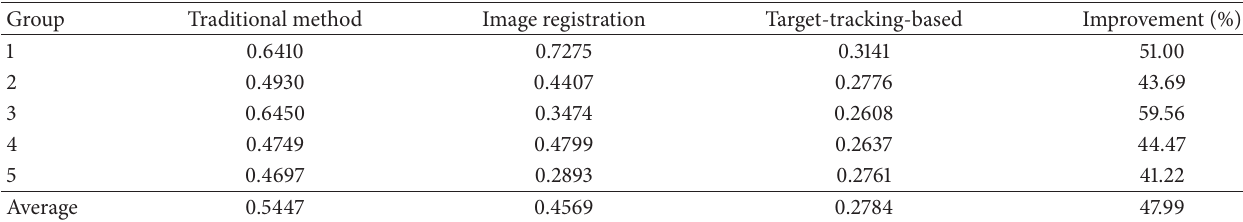
Table 4: The RQE results in airborne remote sensing